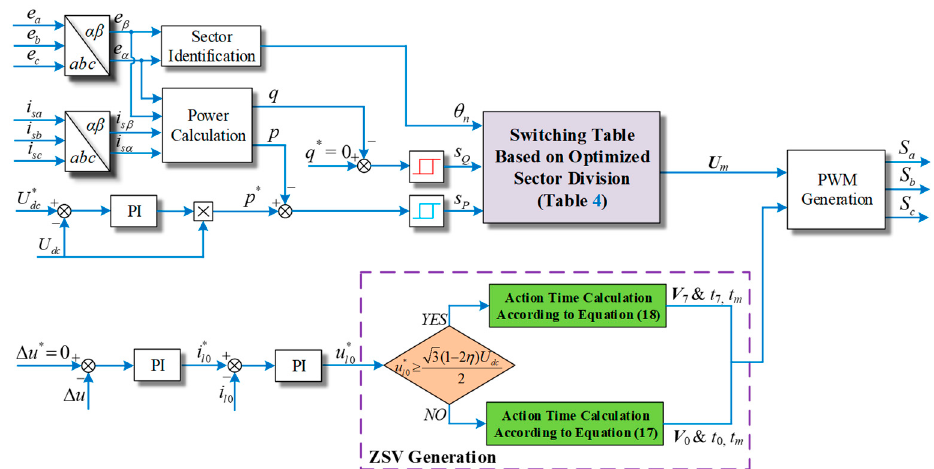
Figure 8. Control diagram of the proposed DPC strategy for TCIBAR.